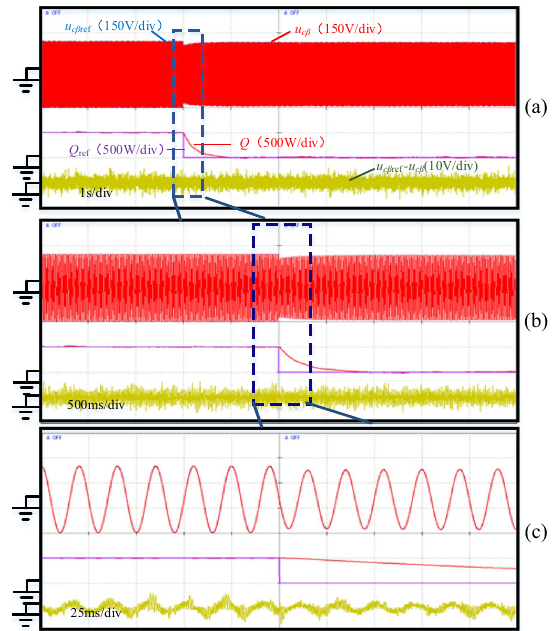
Fig. 12 Experimental waveforms during sudden change of reactive power with error compensation. a 1 s/div. b 500 ms/div. c 25 ms/div